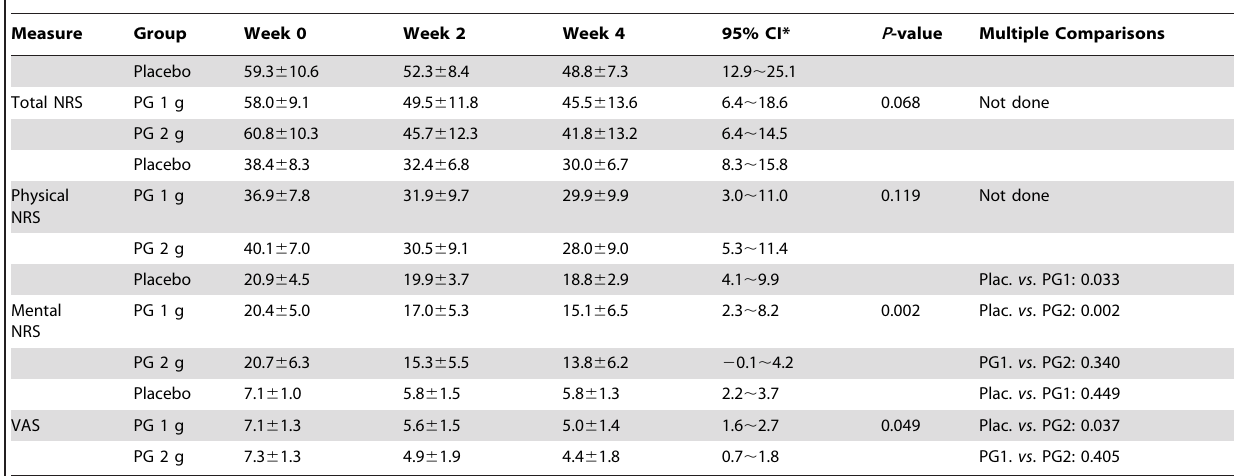
Table 3. Analysis of fatigue scores measured by the NRS and